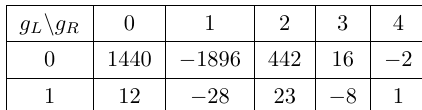
for the homology class β = ( d β